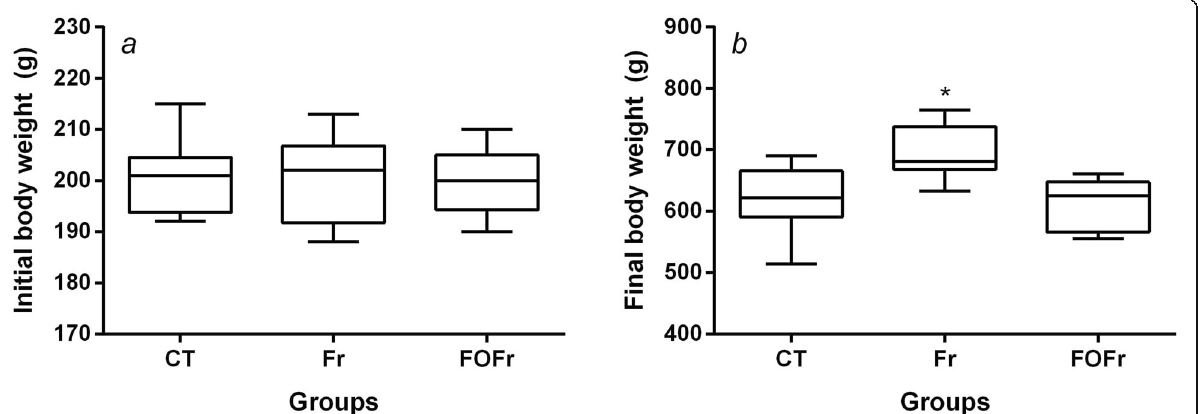
Fig. 1 Body weight. a Initial body weight and b final body weight. Values are mean ± SD. Asterisk indicates a significant difference between groups ( P < 0.05)